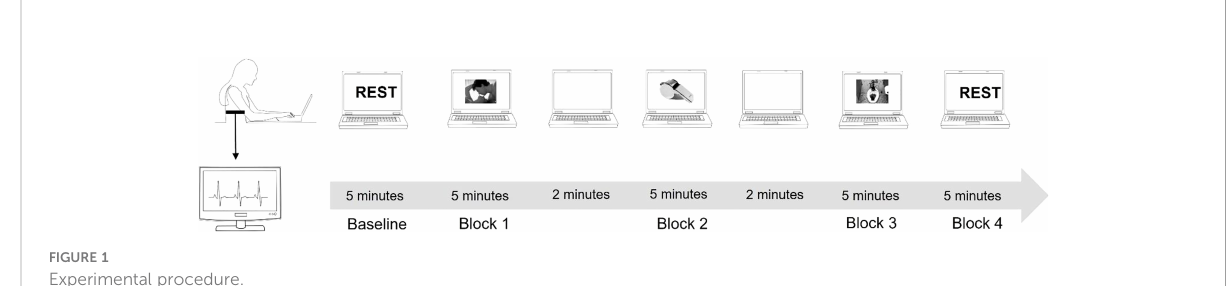
FIGURE 1 Experimental